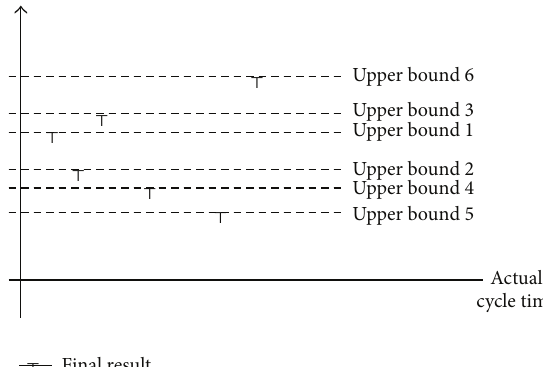
Figure 3: Iterative reduction of the upper bound.